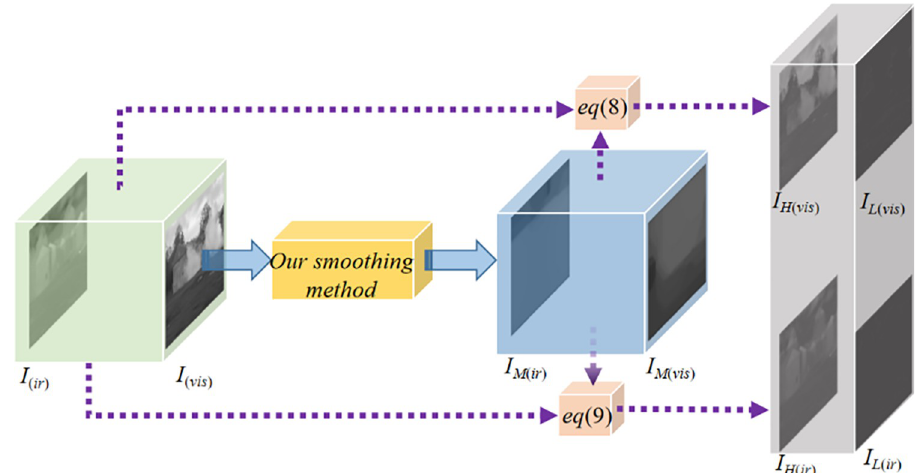
Fig 4. Multi-scale decomposed images for visible-light and infrared images. I (ir) represents the infrared image, I (vis) represents the visible image, and the yellow cube represents the proposed smoothing method. The processed infrared and visible images are denoted as I M(ir) and I M(vis) , respectively. Through Eq (8), the visible image is decomposed into bright detail layer I H(vis) and dark detail layer I L(vis) , while, through Eq (9), the infrared image is decomposed into bright detail layer I H(ir) and dark detail layer I L(ir)